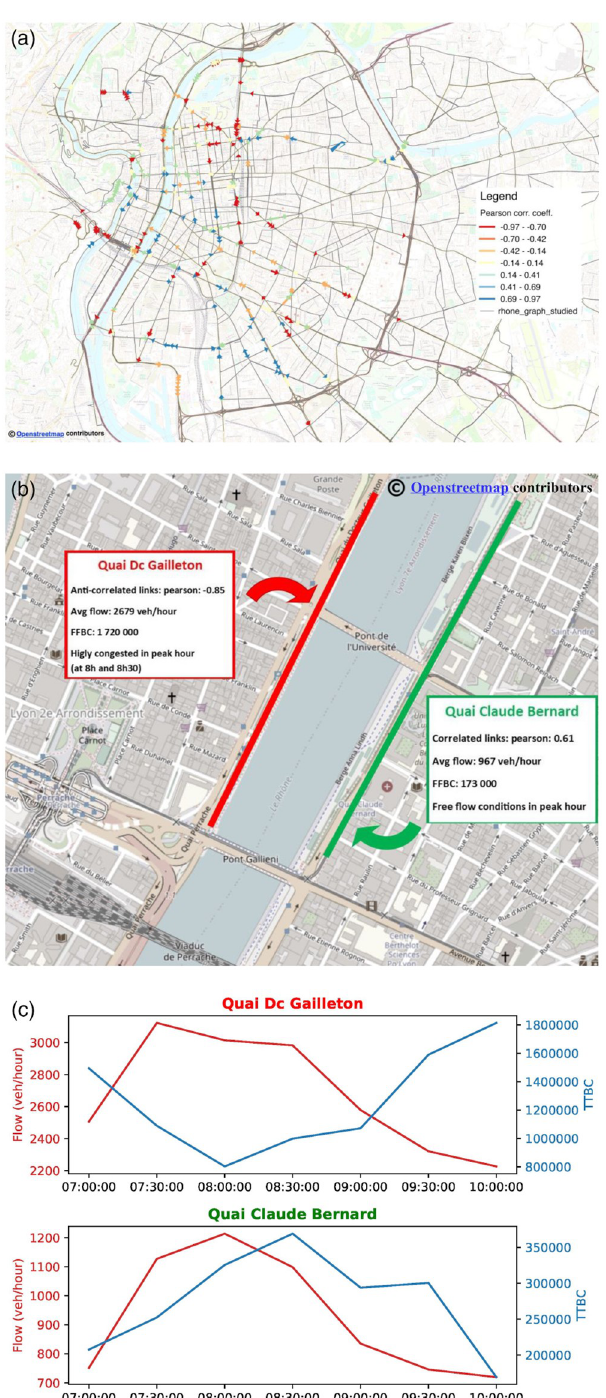
Fig 7. Per-edge temporal correlation between BC and flow (a) and zoom on a specific region (b,c). (a) Per-edge temporal correlation (only edges equipped with loop detectors have a non-null value) (b) Zoom on an area with two roads: Qaui Dr. Gailleton and Quai Claude Bernard (c) Evolution of the TTBC and flow on the road: Qaui Dr. Gailleton and Quai Claude Bernard.